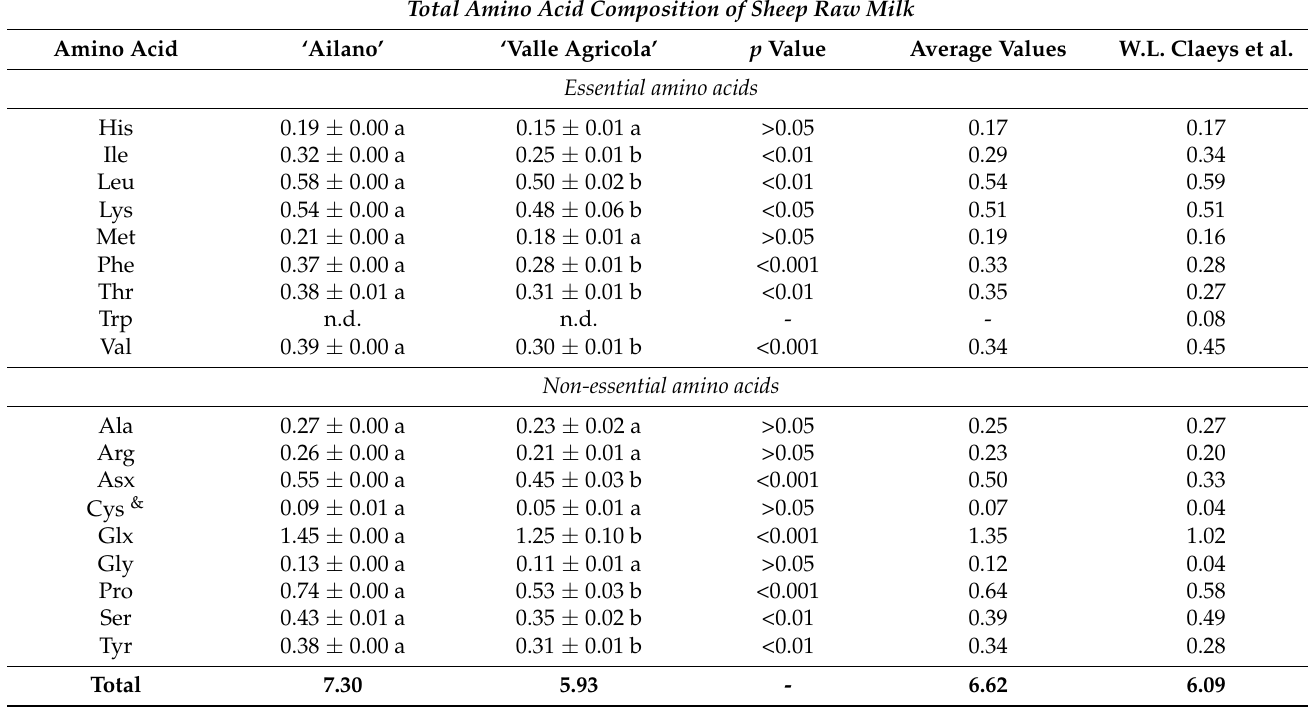
For protein amino acids, a three-letter code has been used. & Cys amount was evaluated after performic acid oxidation. n.d., not detected. Values followed by different letters within a row are significantly ( p < 0.05) different by Bonferroni